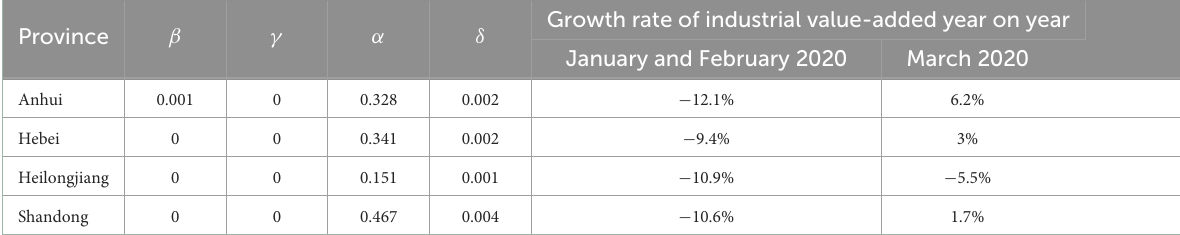
TABLE 4 Optimized parameter values and growth rate of industrial value-added. Growth rate of industrial value-added year on year Province β γ α δ